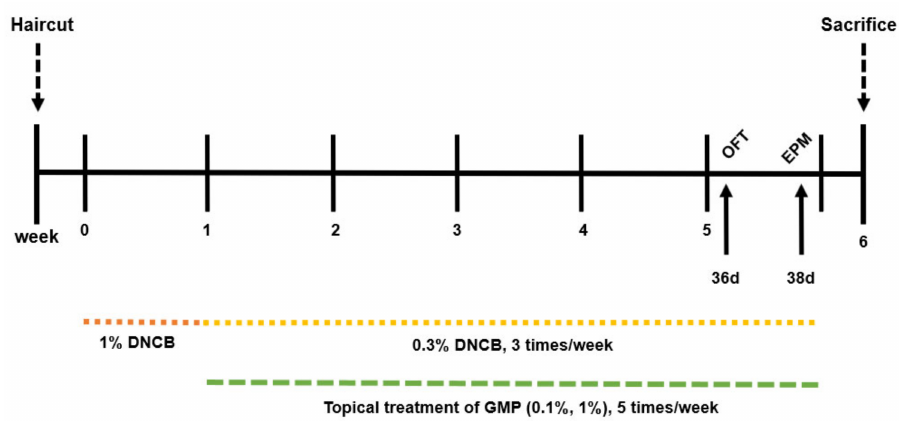
Figure 1. Experimental design for induction of AD and GMP treatment in BALB/c mice. AD, atopic dermatitis; GMP, Gomokpi; DNCB, 2,4-dinitrochlorobenzene; OFT, open field test; EPM, elevated plus